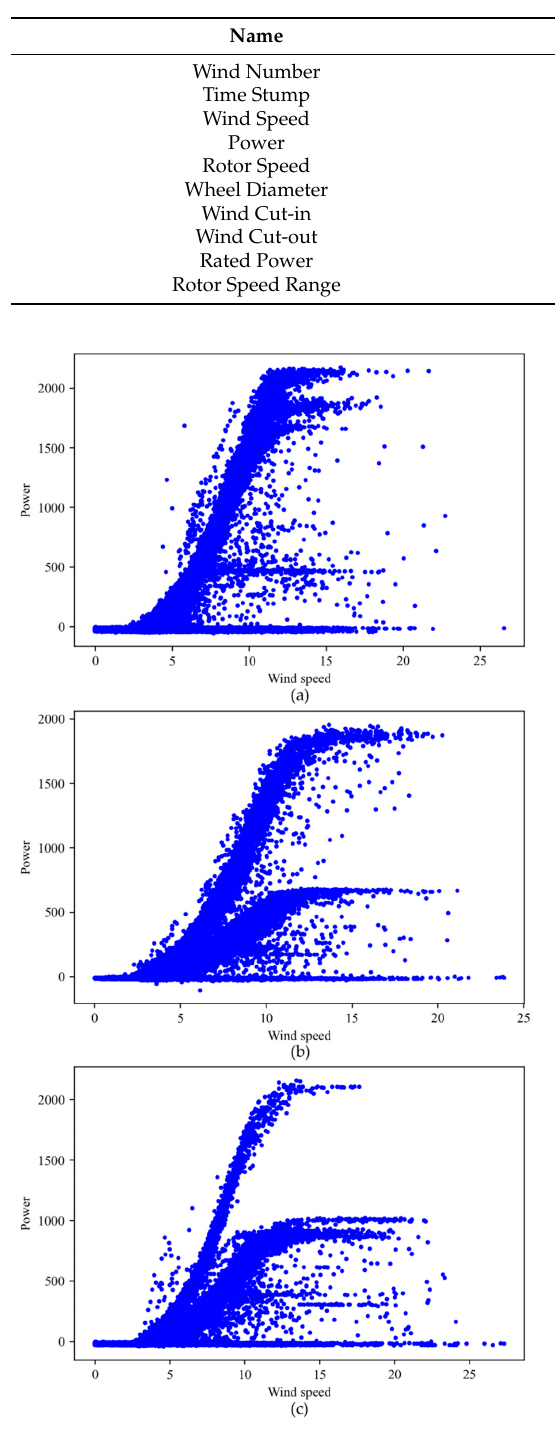
Figure 5. The original data wind speed-power scatter diagram of the three wind turbines: ( a ) #1 wind turbine; ( b ) #2 wind turbine; ( c ) #3 wind turbine.